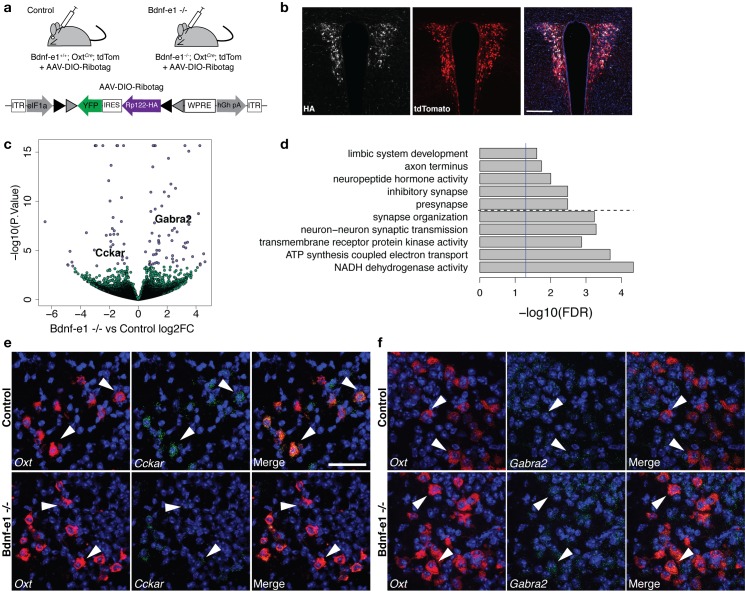
Perturbations in BDNF signaling impact gene pathways critical for plasticity in OXT neurons.(a) Strategy for TRAP in OXT neurons from control and Bdnf-e1 -/- mice (n = 3 per genotype) using AAV-DIO-RiboTag and RNA-seq. (b) Confocal image showing HA (white) and tdTom (red) expression in hypothalamic sections containing the PVN of Bdnf-e1; OxtCre; tdTom mice injected bilaterally with AAV-DIO-Ribotag. Scale bar is 200 μm. (c) Volcano plot of RNA-seq results with Bdnf-e1 -/- IP vs. control IP log2 fold change against -log10 p-value. Blue dots represent genes that are significantly different in Bdnf-e1 -/- IP vs. control IP, including Cckar and Gabra2. Green dots represent non-significant genes. (d) Representative gene ontology (GO) terms in the molecular function, biological processes, and cellular component categories for genes enriched and de-enriched in OXT neurons following disruption of BDNF signaling. Solid vertical line indicates p=0.05 and dotted horizontal line separates downregulated (top) and upregulated (bottom) pathways. (e) Confocal z-projections of Oxt and Cckar transcripts in brain slices containing the PVN from adult control and Bdnf-e1 -/- females visualized with RNAscope in situ hybridization. Cckar transcripts (green) are enriched in Oxt-expressing neurons (red) in control, but not Bdnf-e1 -/- females. (f) Confocal z-projections of Oxt and Gabra2 transcripts in adult PVN of control and Bdnf-e1 -/- females visualized with RNAscope in situ hybridization. Gabra2 transcripts (green) co-localize with Oxt transcripts (red) in control females and appear elevated in Bdnf-e1 -/- females. Scale bar is 50 μm.